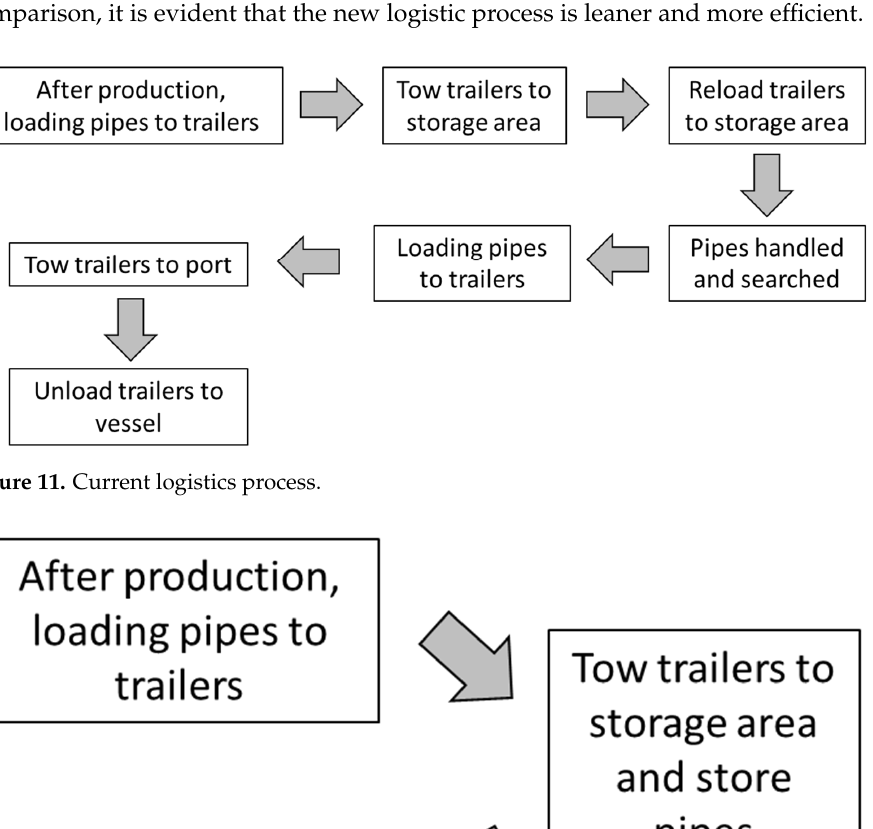
Figure 12. The logistic process with a container solution.